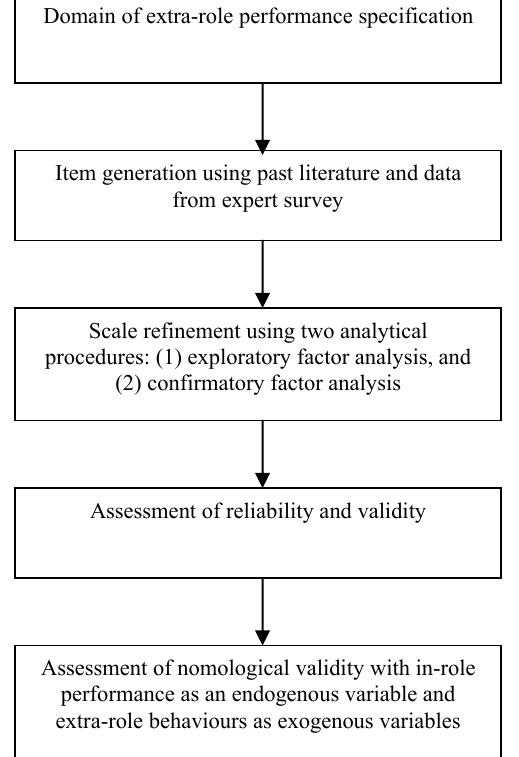
Figure 1: Summary of procedure followed to